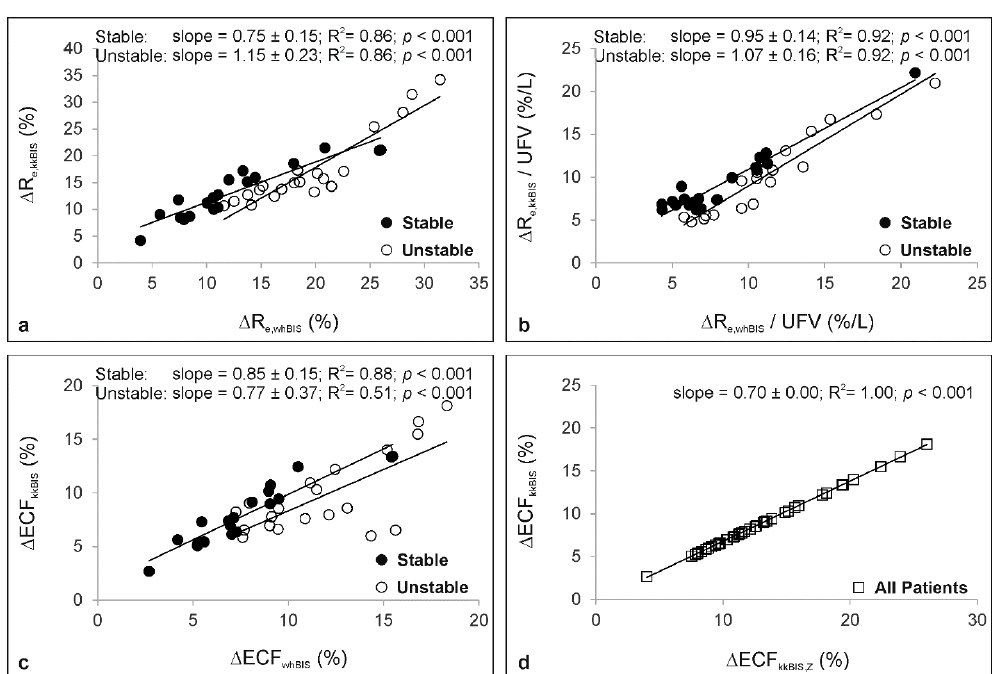
Fig.2: Relationship of relative changes in different BIS parameters estimated on basis of pre-HD and post-HD values from kkBIS and whBIS methods. The relative changes were calculated as (|pre-HD – post-HD|)/pre-HD x 100 for (a) ∆R e (%), (b) ∆R e /UFV (%/L), (c) ∆ECF (%) and (d) ∆ECF (%) according to [15, 16]. Each patient has two